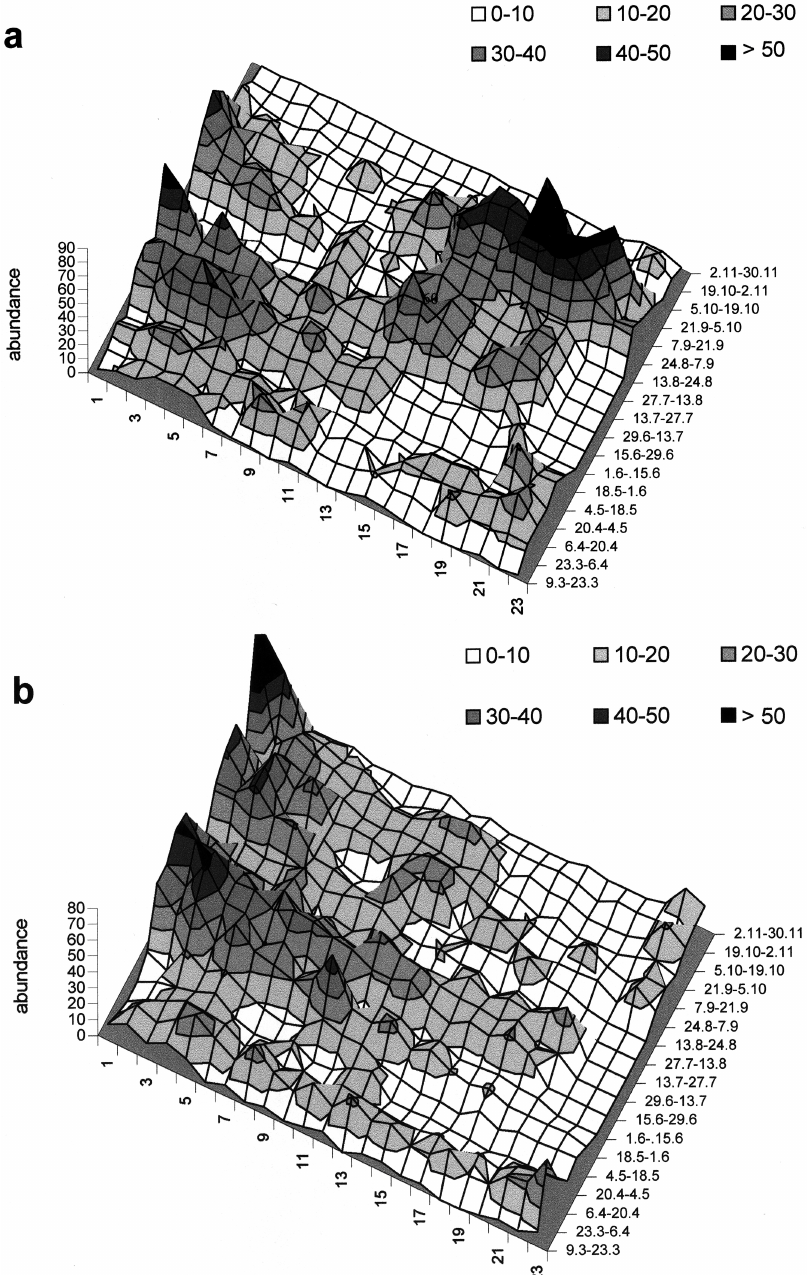
Fig.1. Abundances of Auchenorrhyncha larvae (a) and imagoes (b) in the Bar- ber trap rows in the differ- ent sampling times. Labels 1 to 23 indicate the posi- tion of trap rows along the transect: lower values corre- spond to high relief, higher values are associated with lower relief. The third axis represents the date and time of sampling. The same numbering system is used in Figs 2,